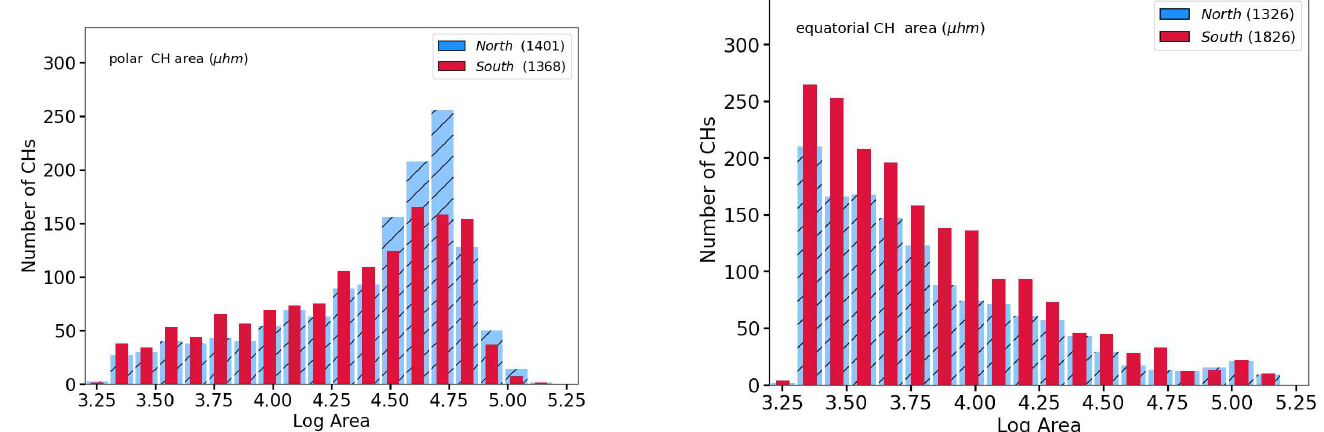
Figure 2. The ( left-hand ) histogram shows the area distribution of polar coronal holes. The ( right- hand ) histogram shows the area distribution for equatorial coronal holes. The number of coronal holes in each considered zone is indicated in